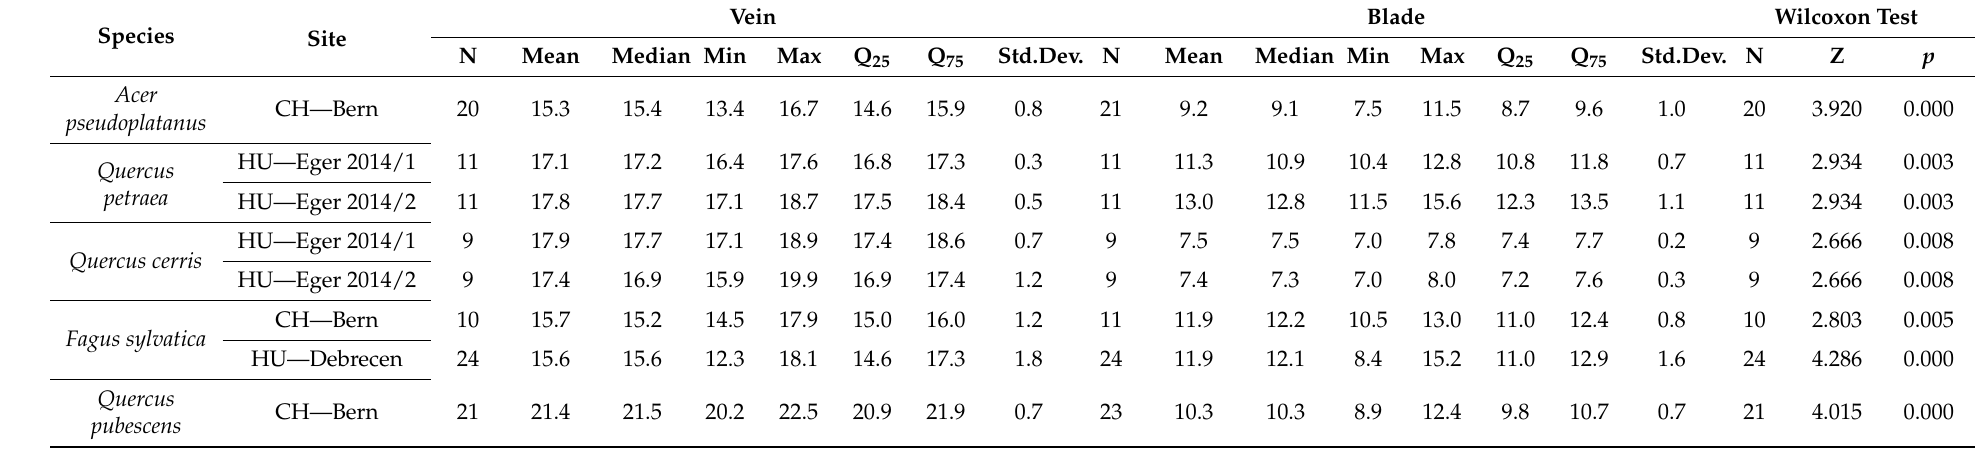
Table 2. Cellulose yield (%) from vein and blade samples of mature broadleaf foliage applying the Jayme-Wise extraction method and results of the paired Wilcoxon test for vein-blade comparisons. Basic statistics include mean, median, minimum value (min), maximum value (max), lower (Q 25 ) and upper quartiles (Q 75 ), and standard deviation (Std.Dev.). Additionally, N , Z, and p denote the number of pairs, z-score, and level of significance, respectively. In the site column, the first two letters denote the Alpha-2 country codes as described in the ISO 3166 international standard followed by the study site name and a year of harvest or age if